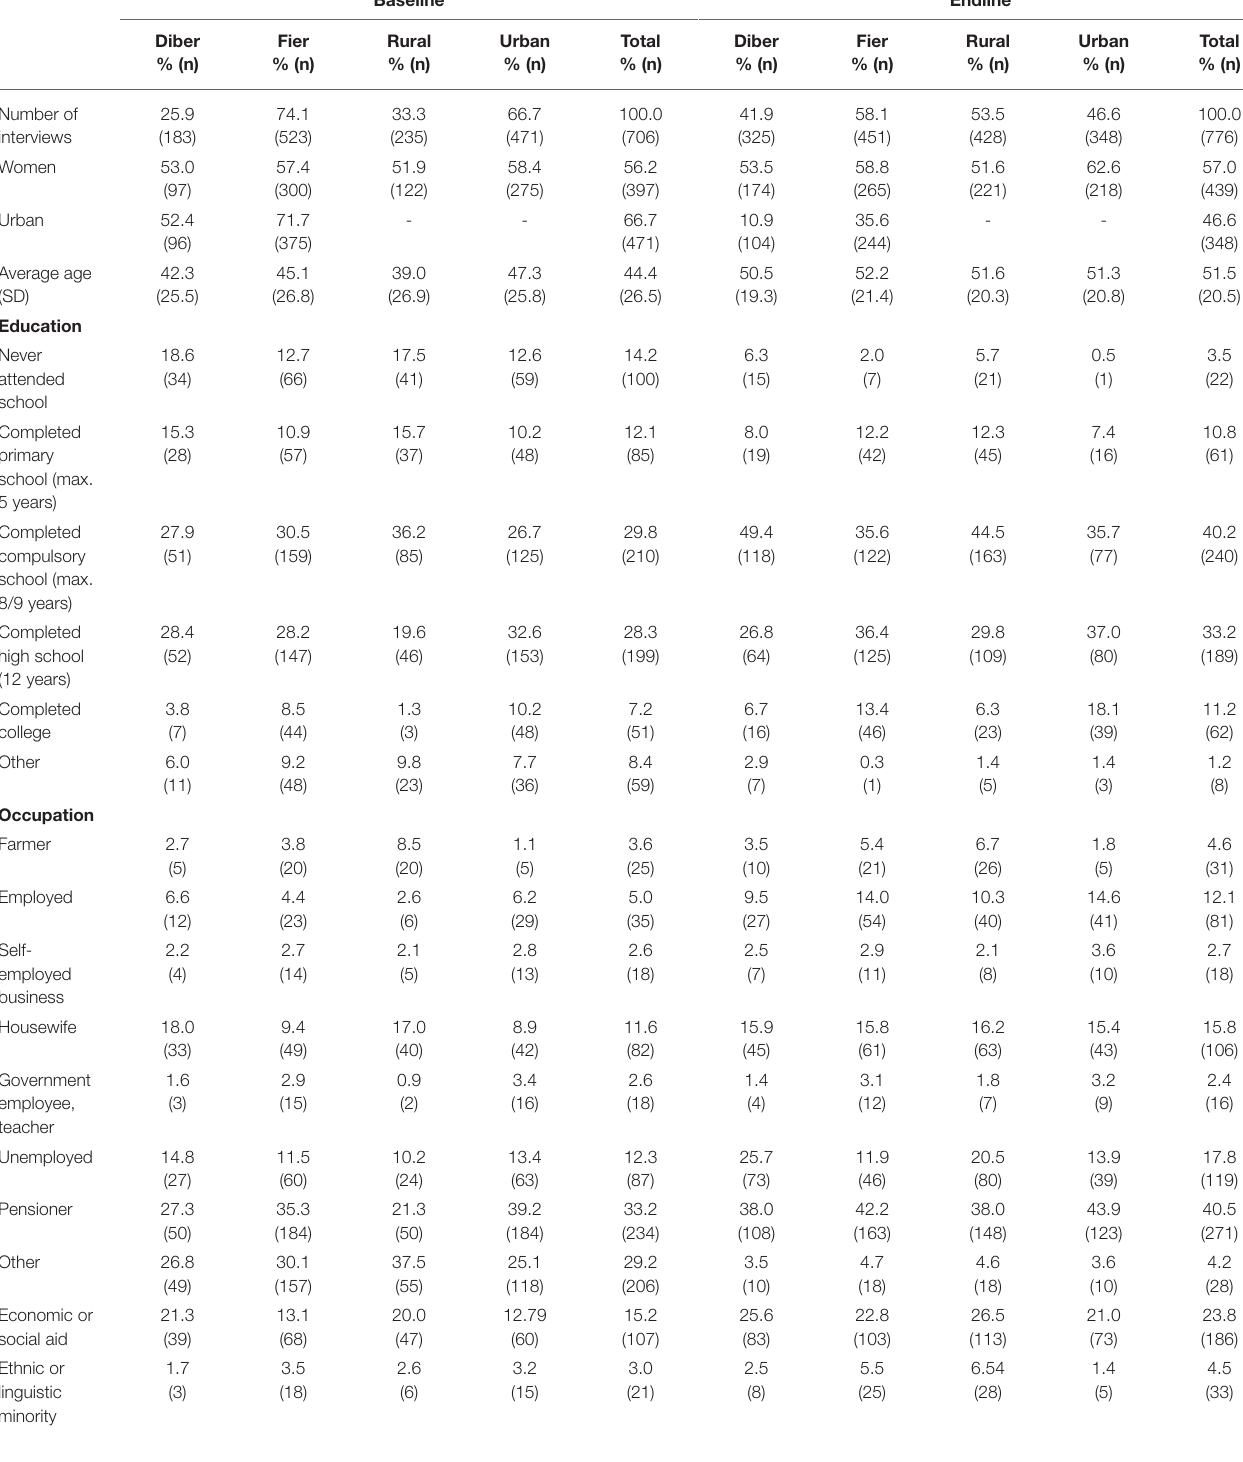
TABLE 4 | Socio-demographic attributes among respondents of exit interviews.